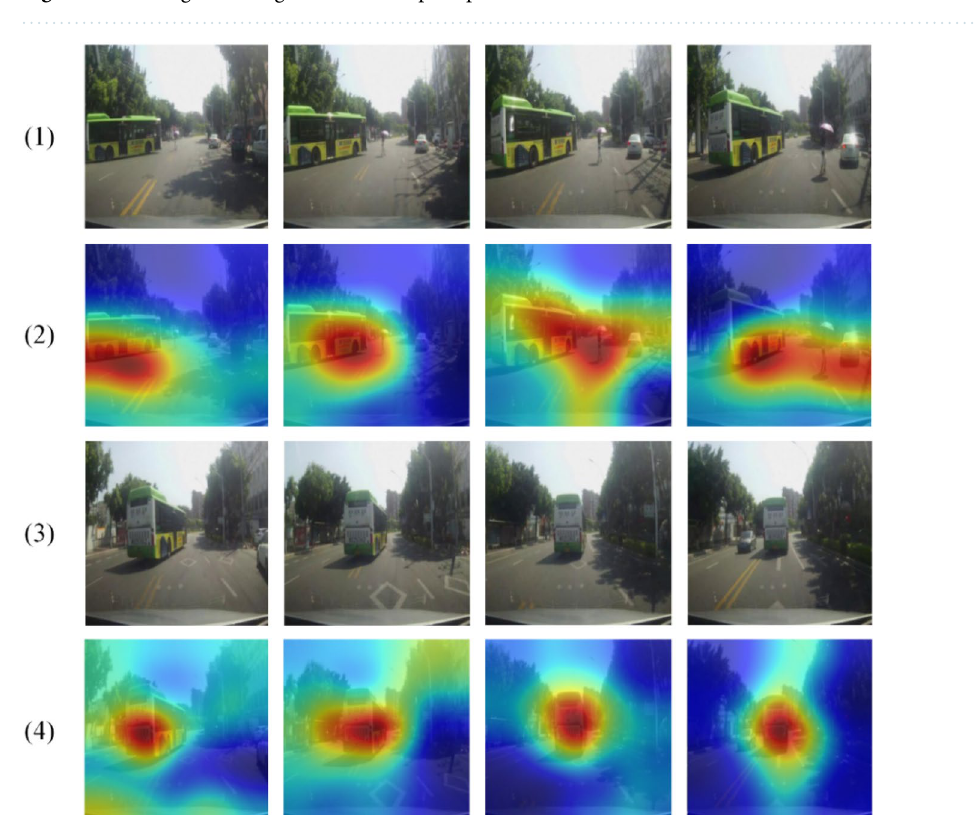
Figure 10. Imaging of driver’s attention